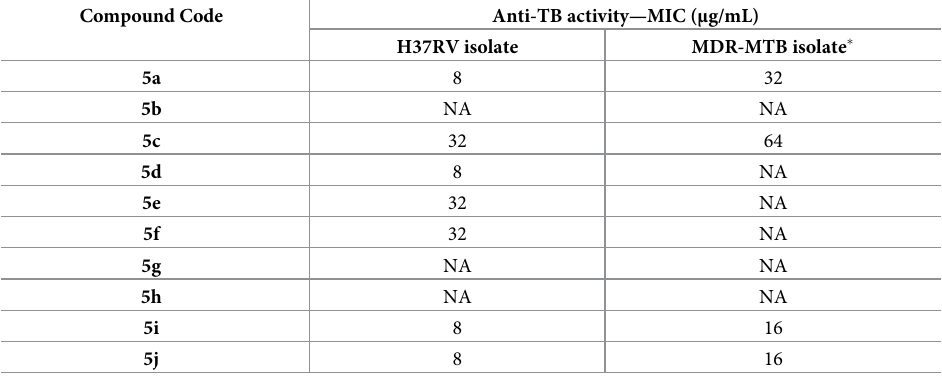
Table 3. In vitro whole-cell anti-TB activity of 7-methoxy-indolizine analogues (5a–j) against H37RV and MDR-MTB isolates. Compound